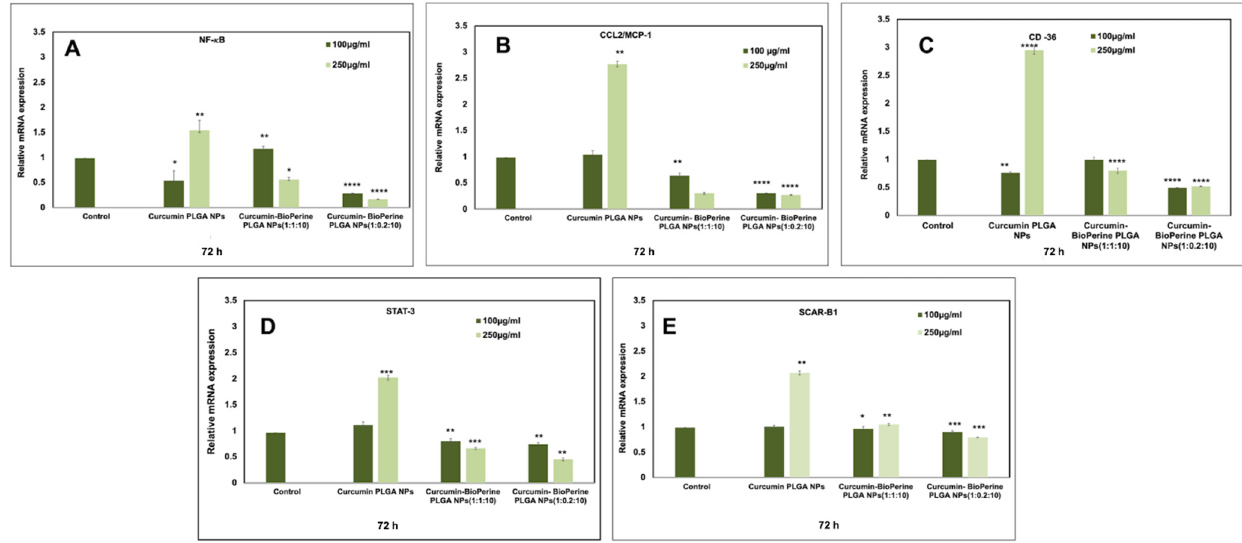
Figure 10. Relative mRNA expression of NF- κ B, CCL2/MCP-1, CD-36, STAT-3, and SCAR-B1 in THP-1 monocyte-derived macrophage cells after treatment with curcumin-Bioperine PLGA NPs (1:1:10 and 1:0.2:10) and Cur-PLGA NPs for 72 h. Both the ratios of curcumin-Bioperine PLGA NPs (250 μ g/mL) demonstrated downregulation of ( A ) NF- κ B, ( B ) CCL2/MCP-1, ( C ) CD-36, ( D ) STAT-3 and upregulation of ( E ) SCAR-B1 compared to 100 μ g/mL. All the data were normalized to GAPDH mRNA expression using the ΔΔ Ct method. (All the data for gene expression studies are expressed as the mean ± S.E.M. Unpaired Student’s t -test was performed to check the statistical significance of the investigation using GraphPad Prism software. Data were considered significant when p < 0.05 (* p ≤ 0.05 ** p ≤ 0.01 *** p ≤ 0.001 **** p ≤ 0.0001). Untreated samples were taken as controls.